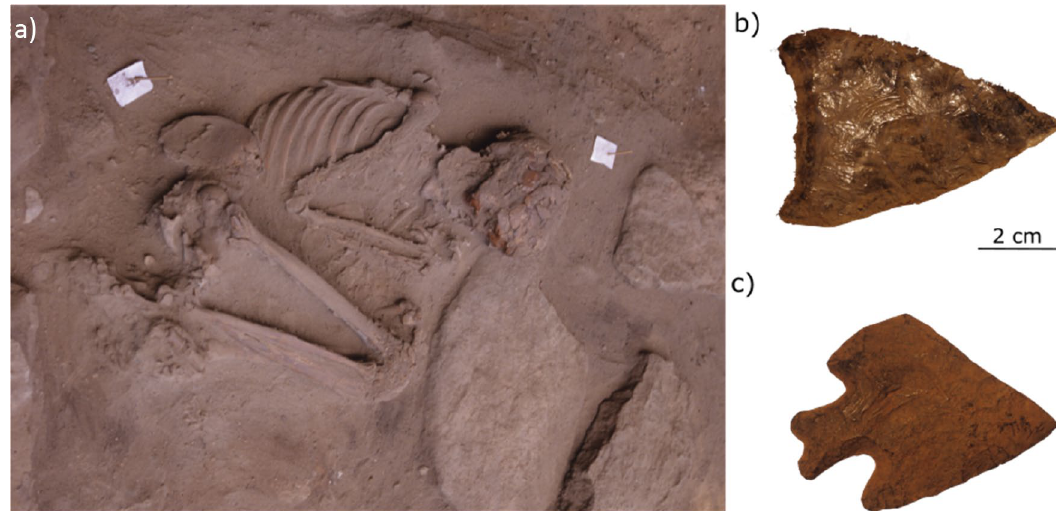
Figure 4. Burial 1 from Toca dos Coqueiros, Serra do Capivara, Brazil: ( a ) Skeleton position; ( b ) Bifacial projectile point made of hyaline quartz; ( c ) Stemmed projectile point made of chert. This Figure has been created from images that belong to the FUMDHAM archives.